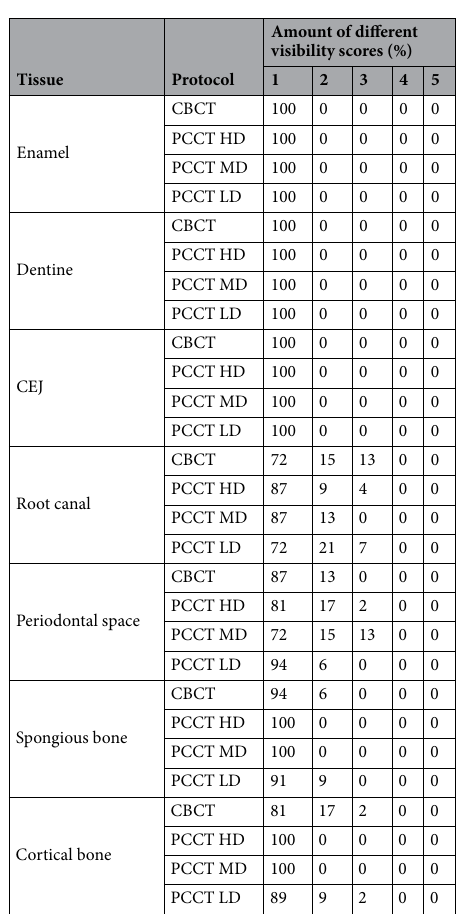
Table 3. Amount of different visibility scores (%) for each structure assessed.